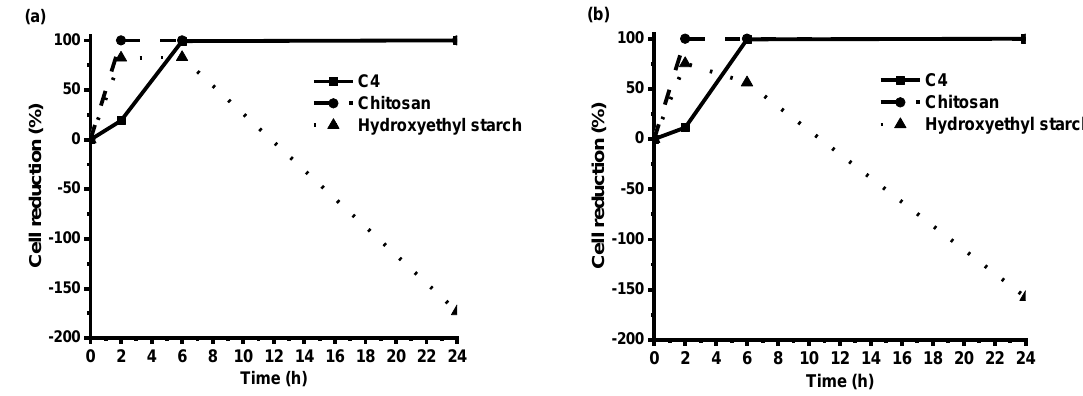
Figure 8. The reduction of E. coli ( a ) and S. aureus ( b ) cells during 24 h of contact time with specimens of polymer C4, chitosan, and hydroxyethyl starch.